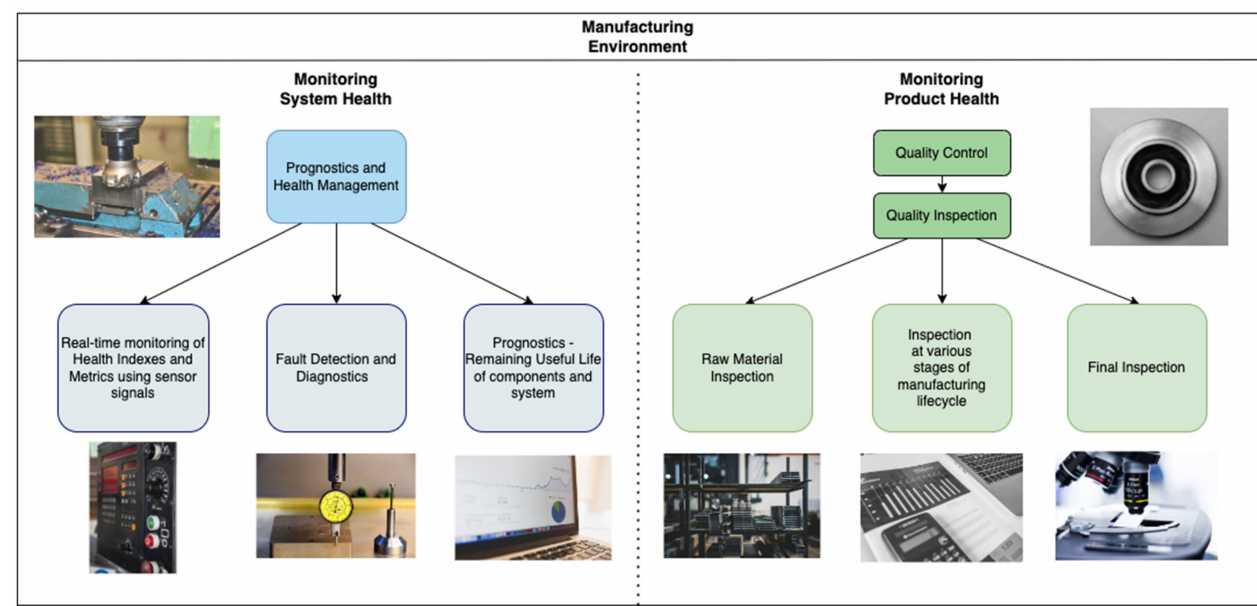
Figure 1. Health Monitoring of the manufacturing environment with PHM and